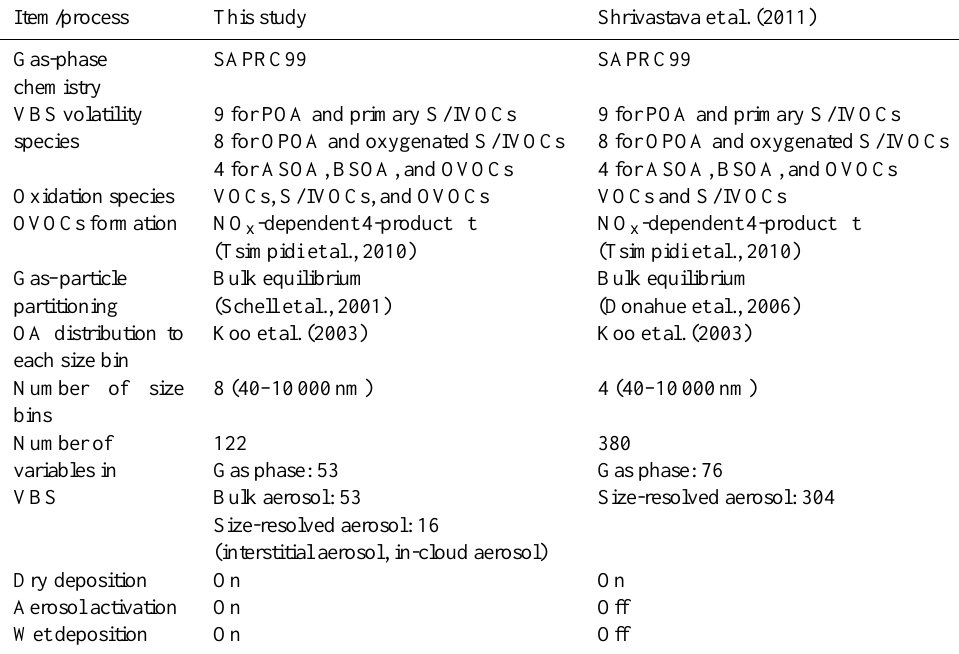
Table 3. Summary of the VBS schemes developed in this study and original WRF-Chem/MOSAIC model.